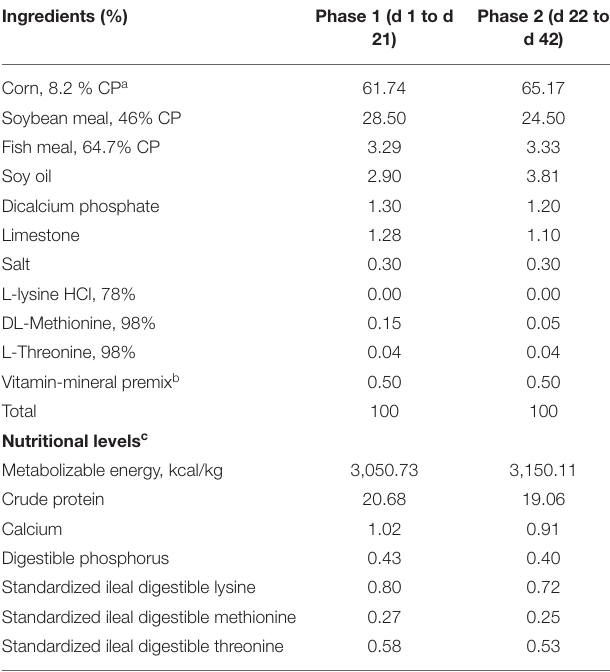
TABLE 1 | Composition and nutrient levels of basal diets (DM a